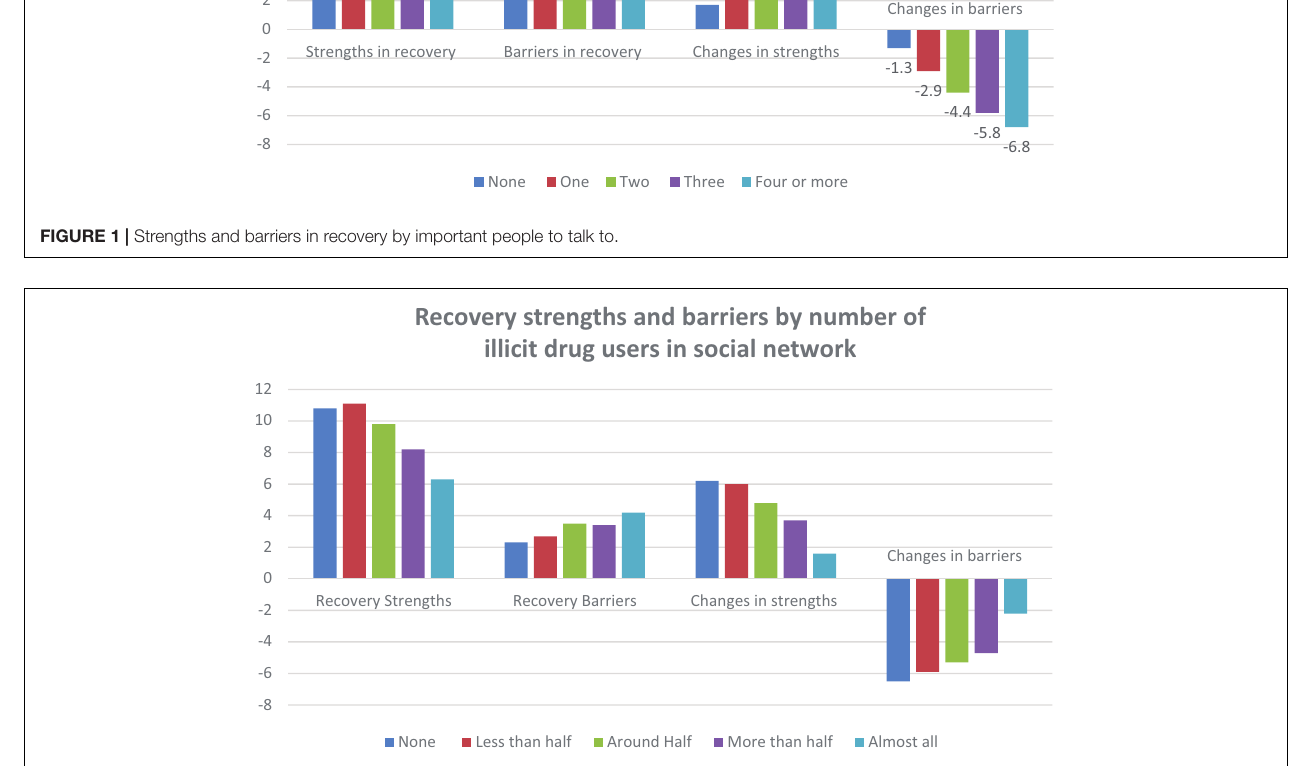
FIGURE 2 | Recovery strengths and barriers by number of illicit drug users in social